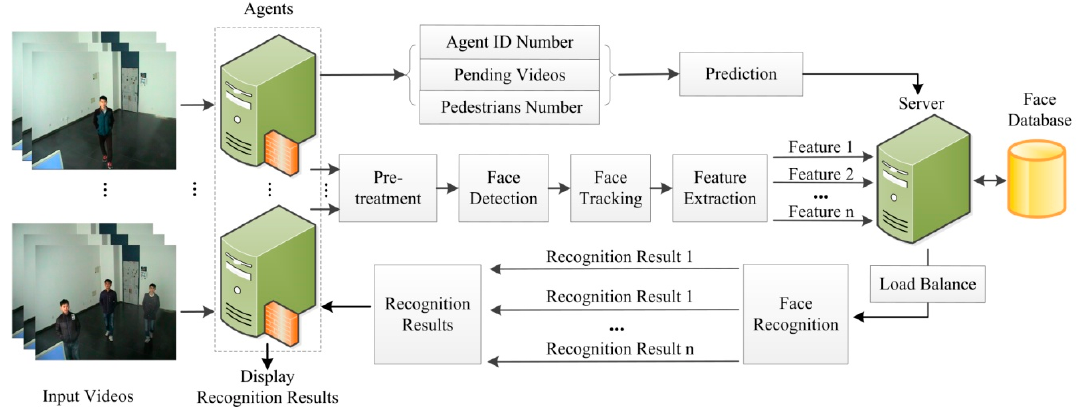
Figure 1. The proposed distributed face recognition model.